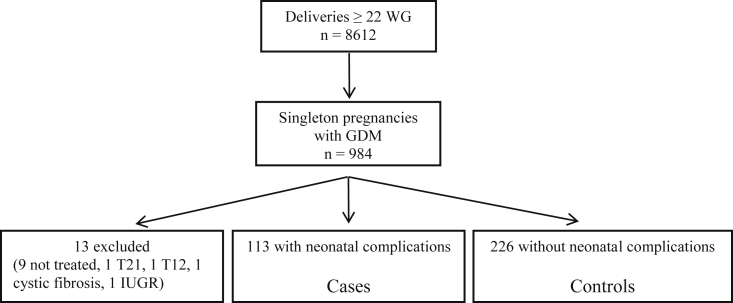
Study profile. WG, weeks of gestation; GDM, gestational diabetes mellitus; T21, trisomy 21; T12, trisomy 12; IUGR, intrauterine growth restriction. Among the 8612 women who delivered during the study period, GDM was diagnosed in 984 (11.4%). Thirteen women were excluded from the study: nine because GDM was not treated, one who had cystic fibrosis, two who delivered infants with a chromosomal anomaly, and one case of severe fetal growth restriction. Macrosomia (n = 102) and/or shoulder dystocia (n = 16) occurred in 113 of the 971 infants (11.6%). Controls were women with GDM who gave birth to children without these complications. Each case was matched with the two controls who delivered next to it, at the same gestational age ±1 WG.